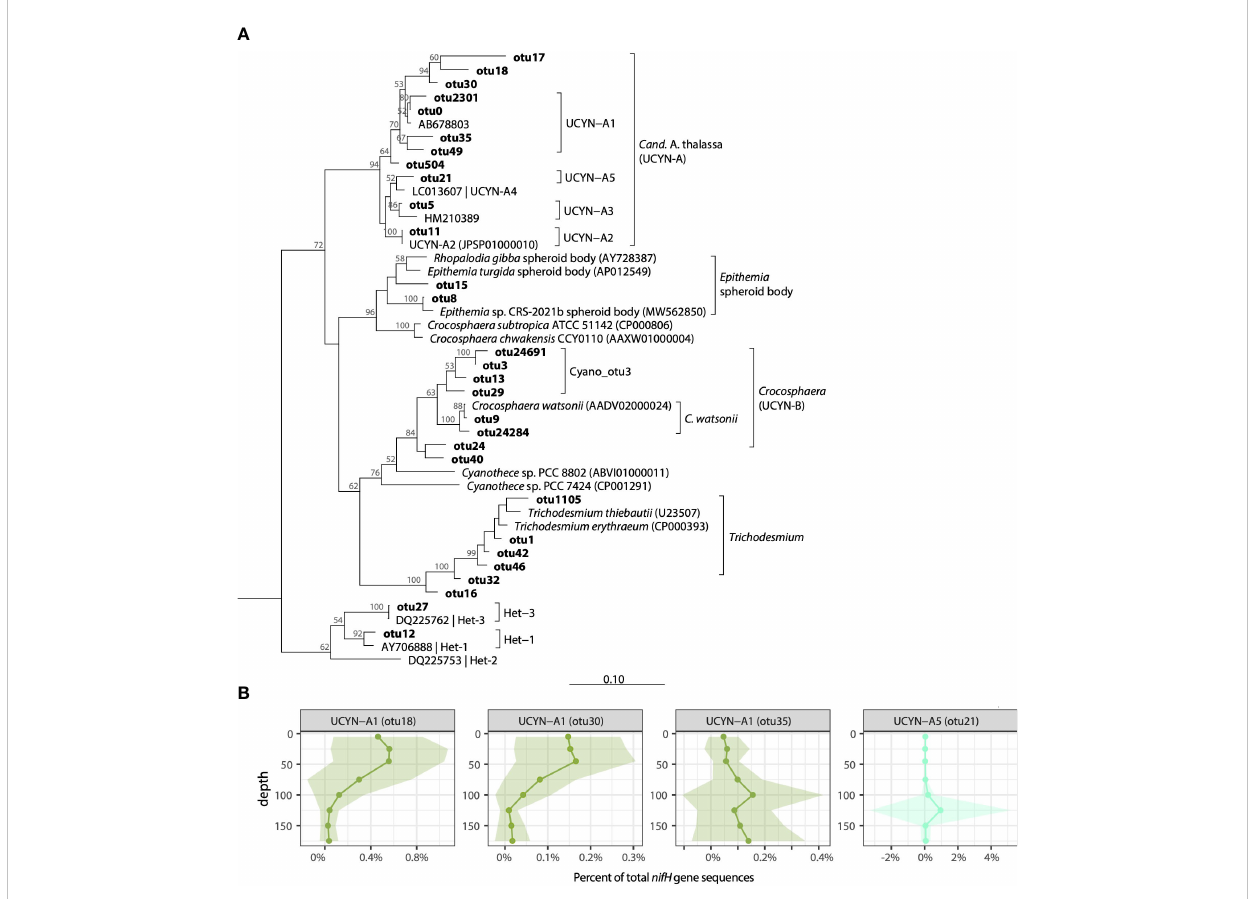
FIGURE 3 Cyanobacterial diazotroph diversity at Stn. ALOHA. (A) Neighbor-joining nucleotide tree of cyanobacterial OTUs along with cultivated representatives. (B) Depth pro fi les of selected UCYN-A OTUs plotted as a percent of total nifH gene sequences in the rare fi ed dataset. Solid lines represent mean values, shading represents ± 1 standard